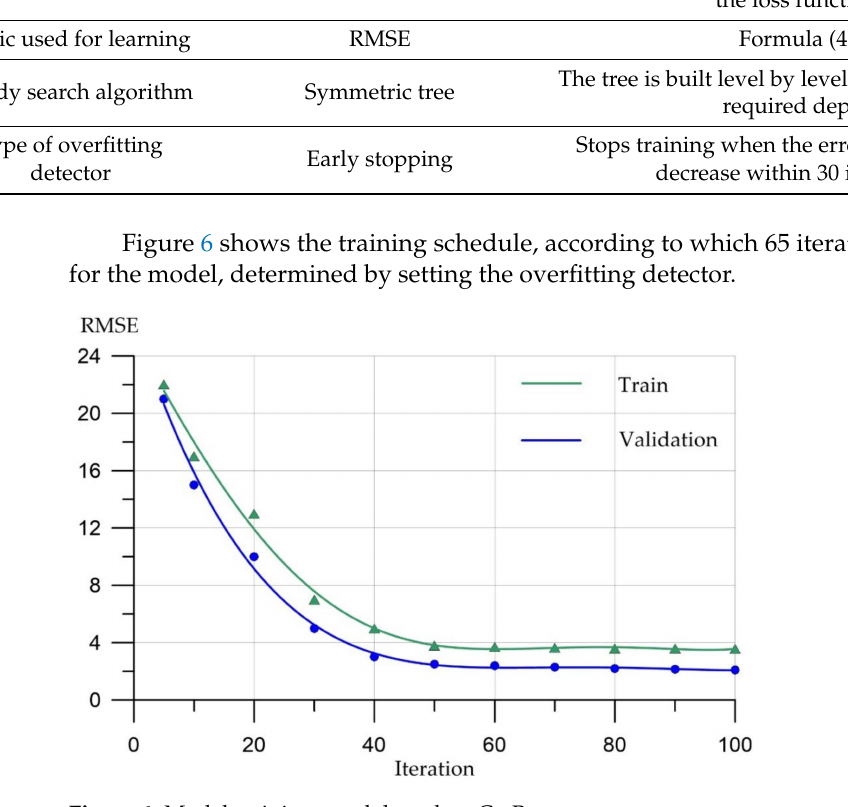
Figure 6. Model training graph based on CatBoost.